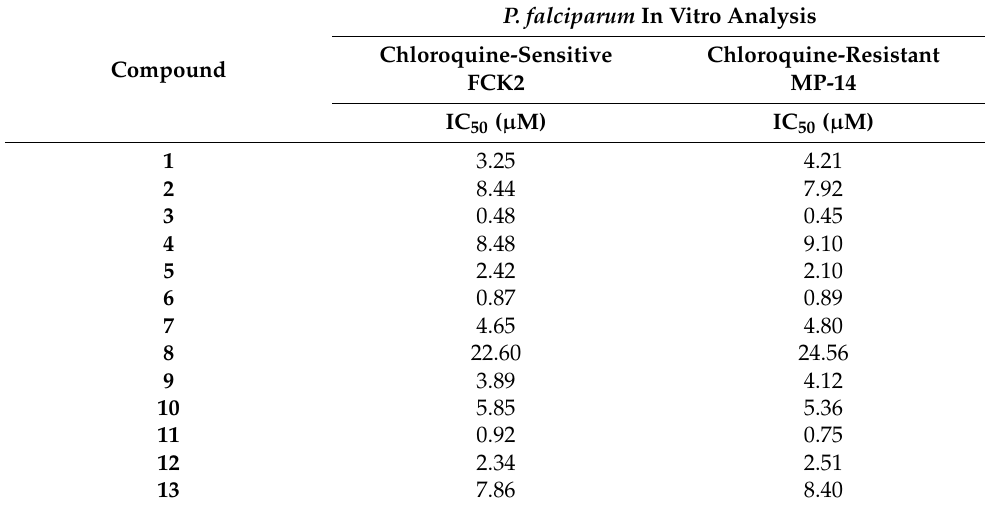
Figure 10. Reaction scheme showing the synthesis of isoxazole and pyrazole derivatives of curcu- min. Table 2. Data reported by Mishra et al. [38] showing the in vitro efficacy of curcumin and its derivatives against P. falciparum .